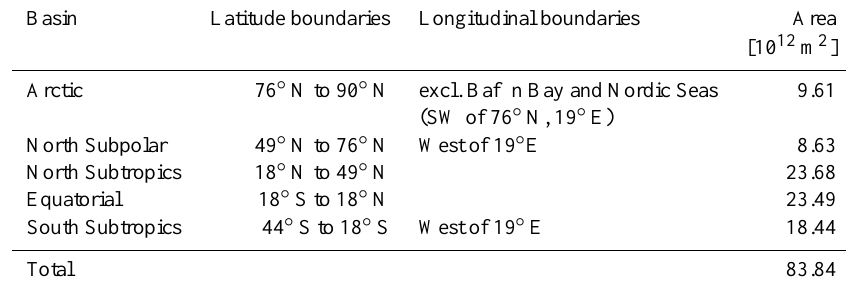
Table 3. Latitudinal boundaries of subregions in the Arctic and